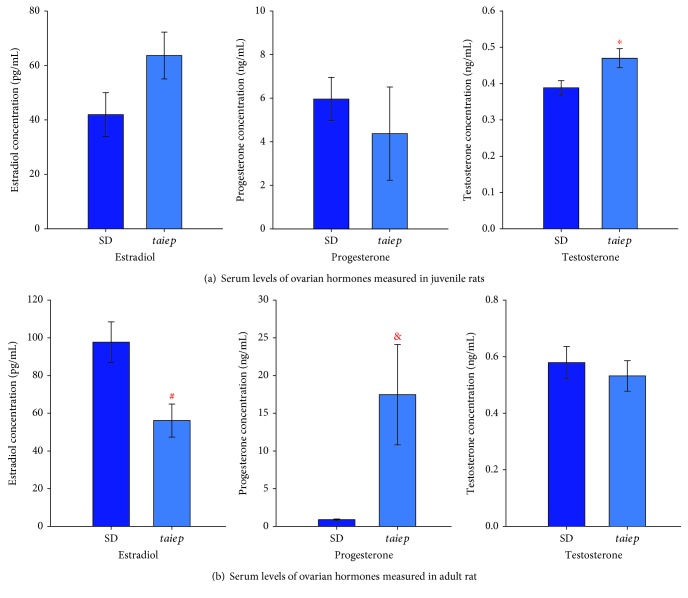
Serum levels of ovarian hormones in the juvenile and adult Sprague–Dawley and taiep rats. (a) Serum levels of estradiol, progesterone, and testosterone in the juvenile Sprague–Dawley and taiep rats. The error bars represent the standard error of measurements for 6 Sprague–Dawley rats (SD) or taiep rats. (b) Serum levels of estradiol, progesterone, and testosterone in adult Sprague–Dawley and taiep rats. The error bars represent the standard error of measurements for 6 Sprague–Dawley rats (SD) or taiep rats. SD: Sprague–Dawley. ∗p ≤ 0.033, #p ≤ 0.009, and &p ≤ 0.017; Student's t-test.